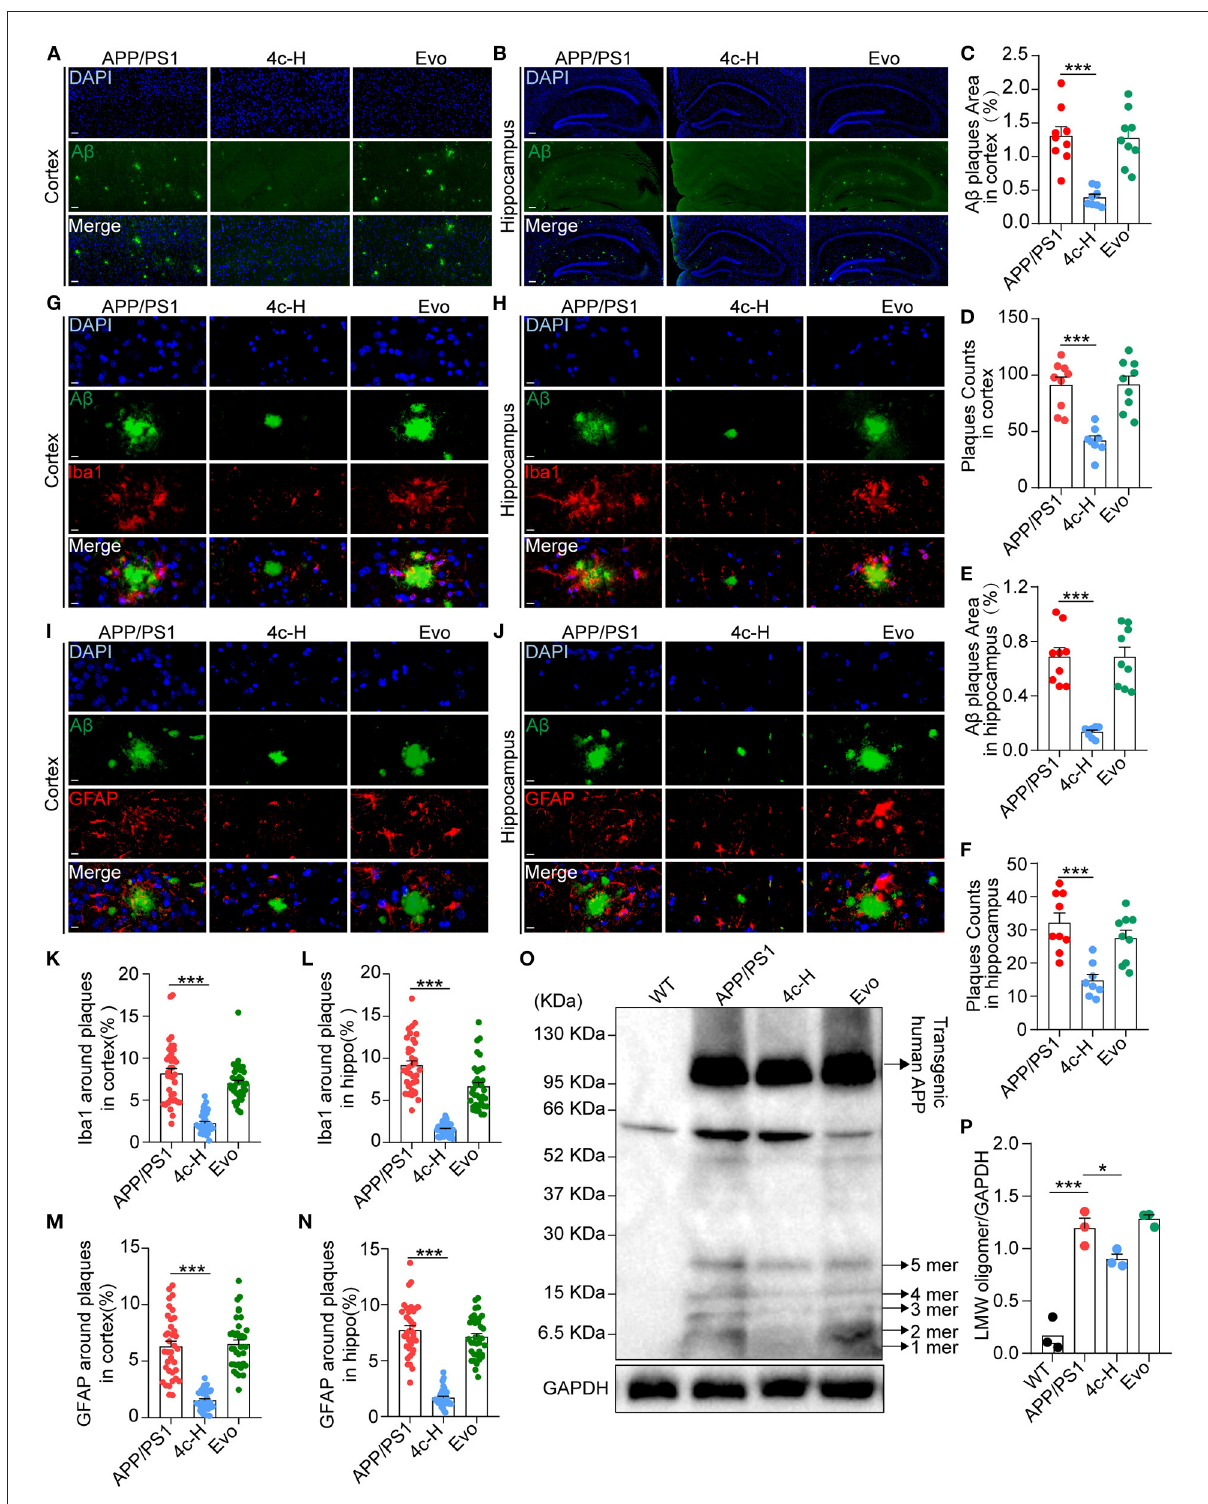
FIGURE6 Observation of A β pathology in the brain in APP/PS1 mice. After the cognitive behavior evaluations, mice from the APP/PS1, 4c-H, and Evo groups were selectively sacrificed, and the paraffin sections of the brain were prepared by a standard pathological procedure. (A, B) A β in the cortex and hippocampus was observed by immunofluorescence staining with an anti-6E10 antibody (green) and counterstained with DAPI (scale bar = 200 µ m). (C–F) The A β plaque area and plaque counts in the cortical and hippocampal regions were quantified by ImageJ ( n = 9). (G, H, K, L) Microglia around A β plaques were observed by double immunofluorescence staining with anti-6E10 (green) and anti-Iba1 (red)